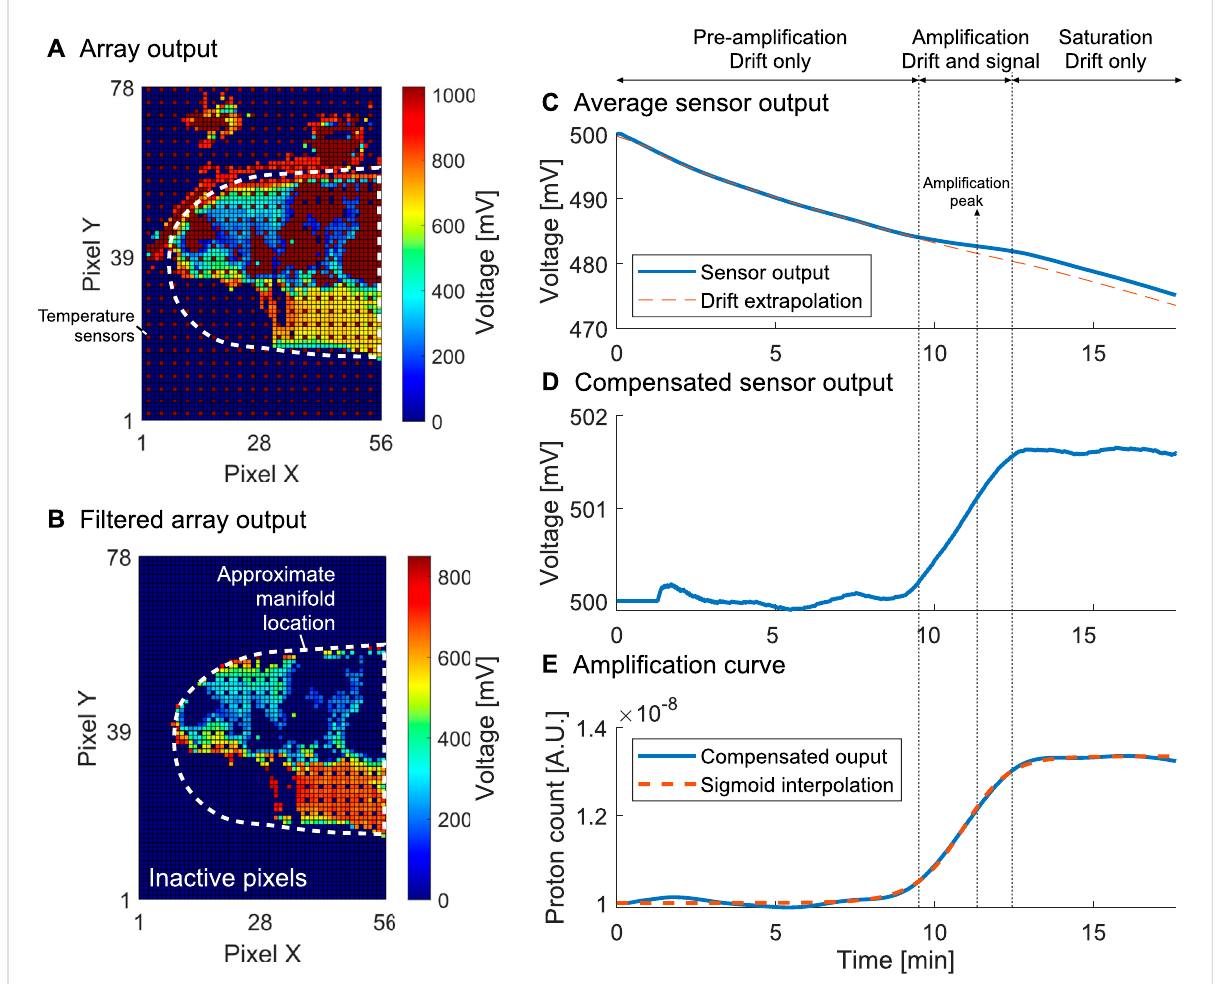
FIGURE 4 Processing work fl ow for the electrochemical sensor output illustrated for sample 3. (A). Unprocessed initial array output with shown temperature sensors and approximate manifold location. (B). Initial array output after fi ltering out inactive sensors. (C). Sensor output averaged over activesensorswithdriftextrapolation. (D). Averagedsensoroutputwithdriftcompensation. (E) .Linearisedcurvewithsigmoidal fi ttingcorresponding to the fi nal ampli fi cation curve from which a TTP can be